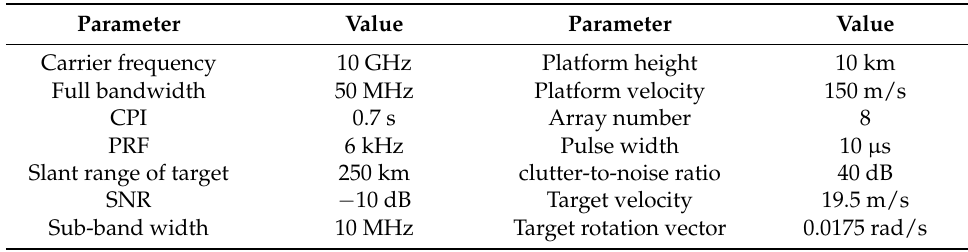
Table 1. Simulation Parameters.